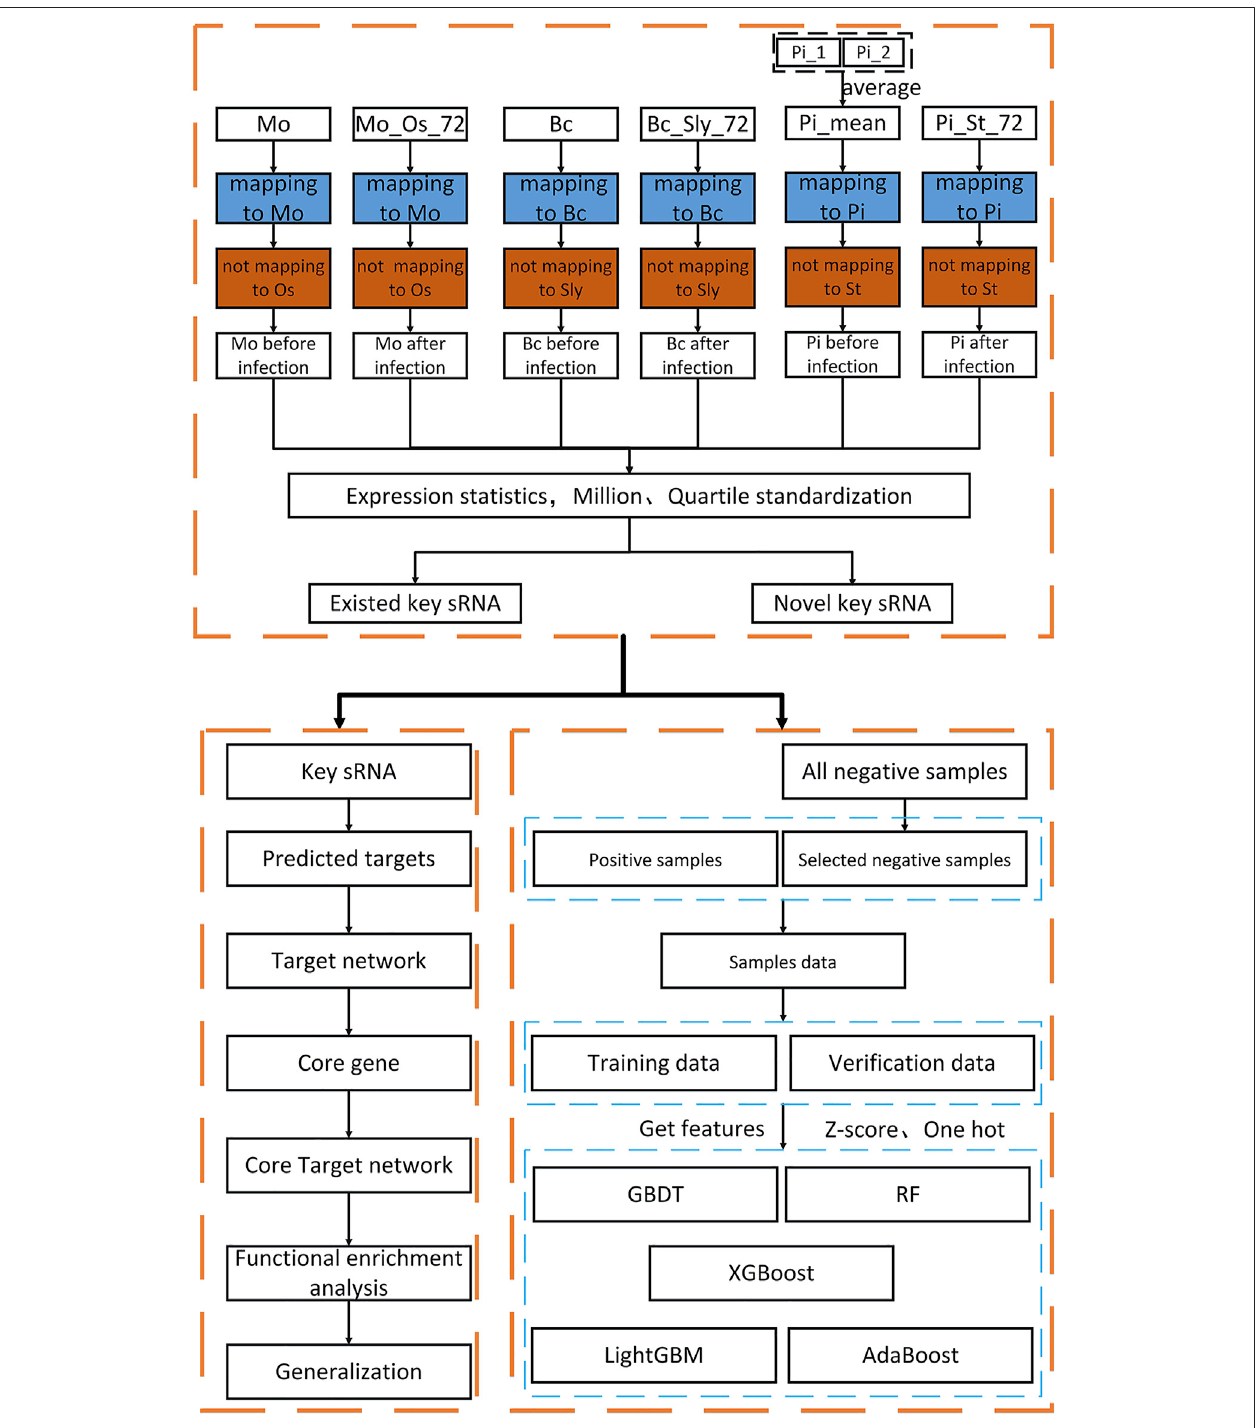
FIGURE 1 | Overall research fl ow chart. In the fi rst and fourth rows, Mo is the abbreviation of Magnaporthe oryzae sRNA, MO_Os_72 is the abbreviation after Magnaporthe oryzae sRNA infecting Oryza sativa 72 h, Bc is the abbreviation of Botrytis cinerea sRNA, Bc_Sly_72 is the abbreviation after Botrytis cinerea sRNA infecting Solanum lycopersicum 72 h, Pi is the abbreviation of Phytophthora infestans sRNA, Pi_St_72 is the abbreviation after Phytophthora infestans sRNA infecting Solanum tuberosum 72 h. In the second and third rows are the corresponding genomes.